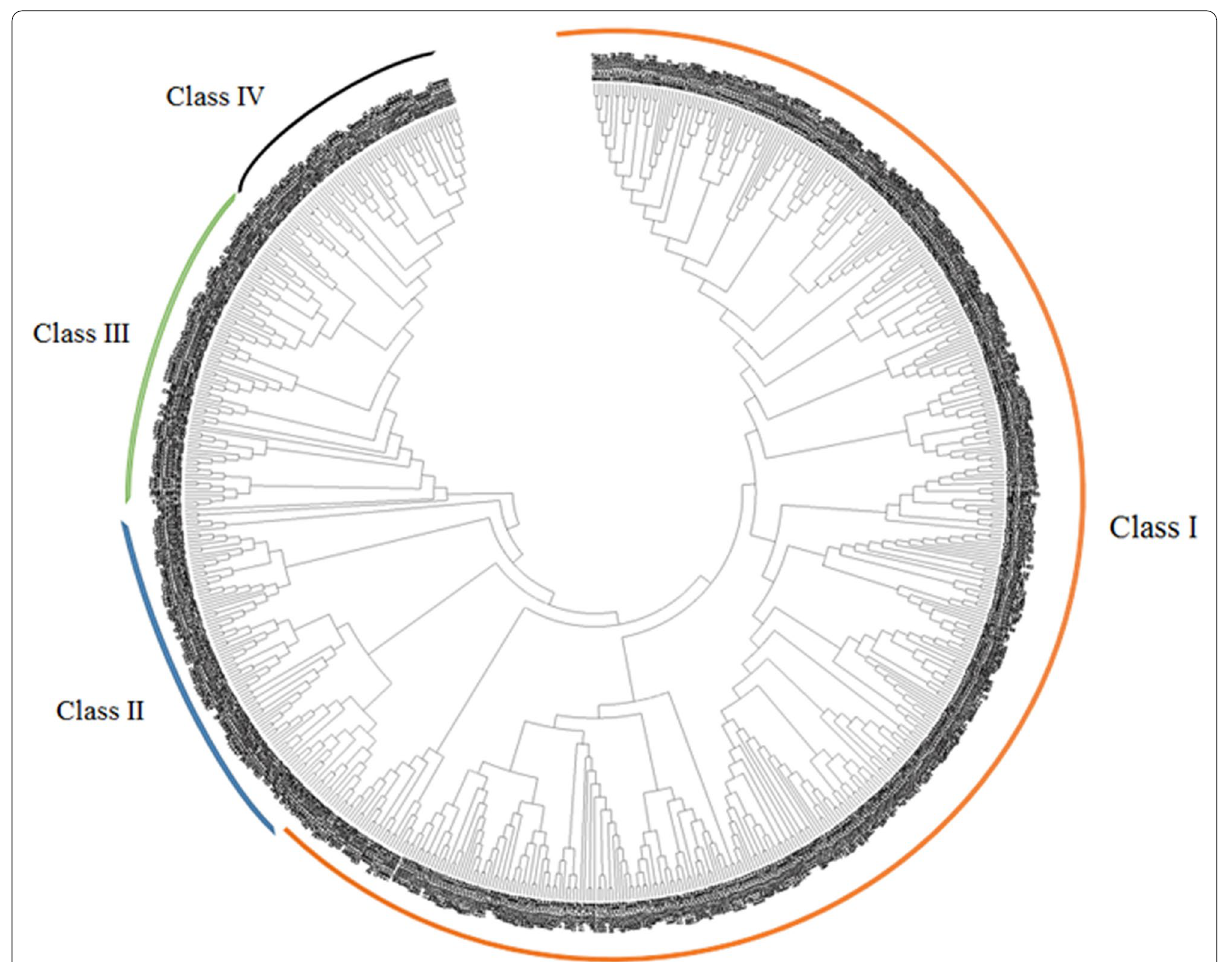
Fig. 4 Phylogenetic relationships of U-box proteins in seven plant species ( S.tubersum with A . thaliana , S . lycopersicum , G . hirsutum , O . sativa , Z . maize , C . mytifolia , and T . aestivum ). The tree was constructed using the MEGA 6.0 software by the maximum likelihood